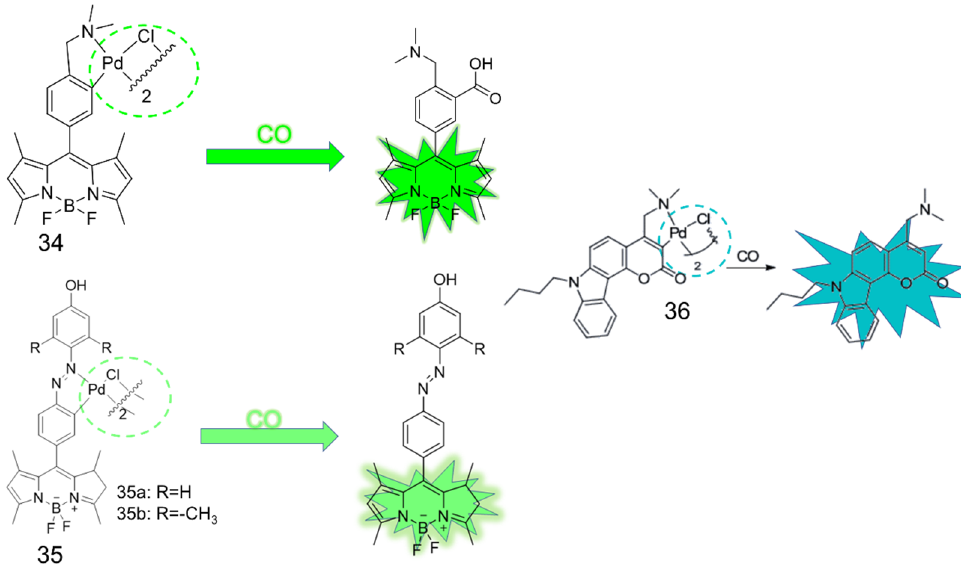
Figure 13. The chemical structures of some CO fluorescent probes constructed based on palladium metal-mediated carbonylation or protonation hydrolysis reactions.